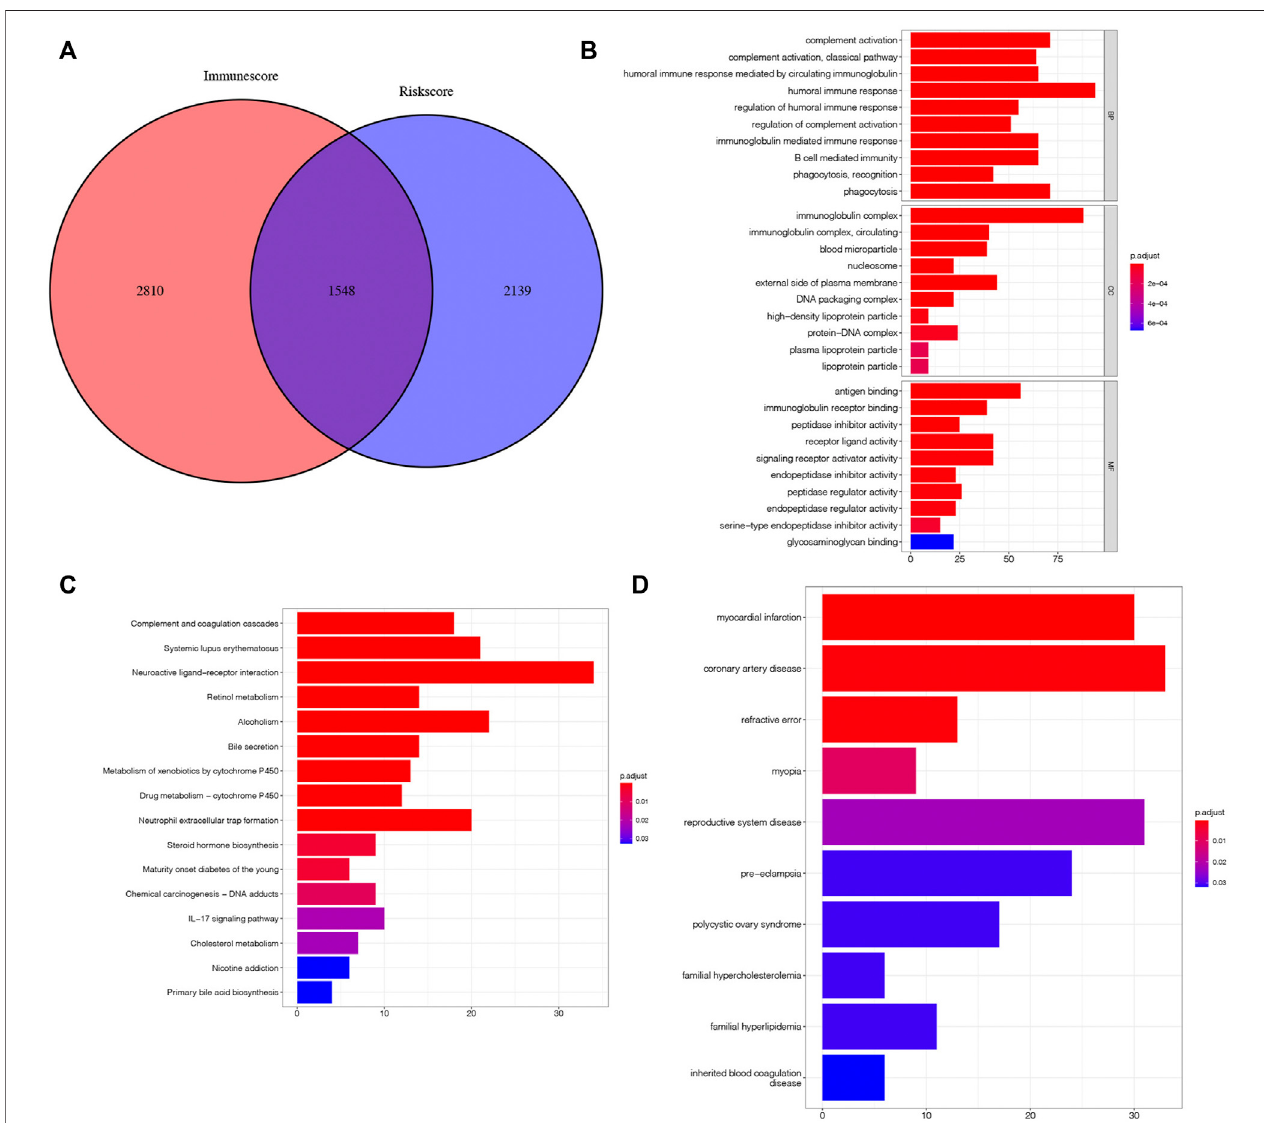
FIGURE12| Searchforrisk-immune-relatedgenes. (A) Intersectiongeneofriskscoreandimmunescore. (B – D) GO,KEGG,DOenrichmentanalysisofprognostic risk-immune-related genes.